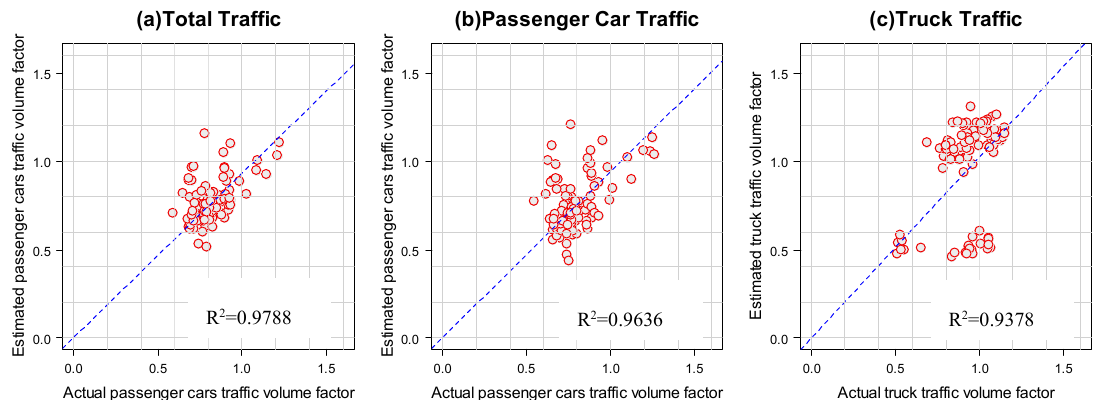
Figure 16. The accuracy of temporal transferability for naive regression model at Leduc Highway 2.